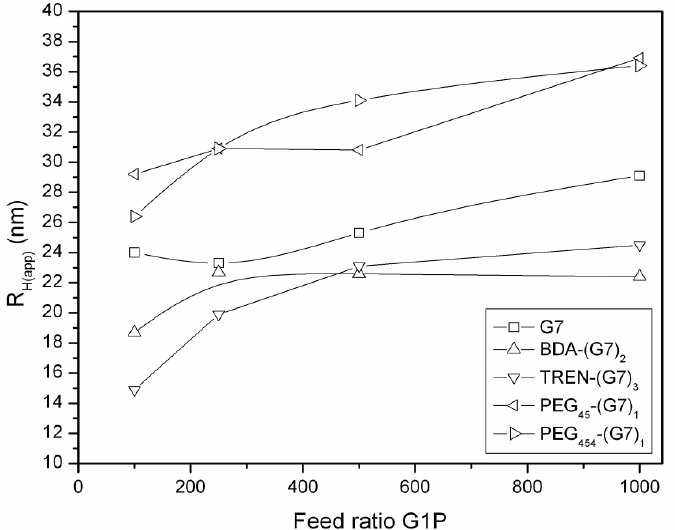
Figure 10. Relation of the apparent hydrodynamic radius with the feed ratio